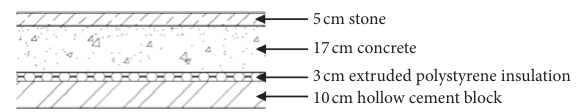
Figure 15: External wall of Ras Alain Multipurpose Hall (Ras Alain Multipurpose Hall drawings, 2016, adapted by author).